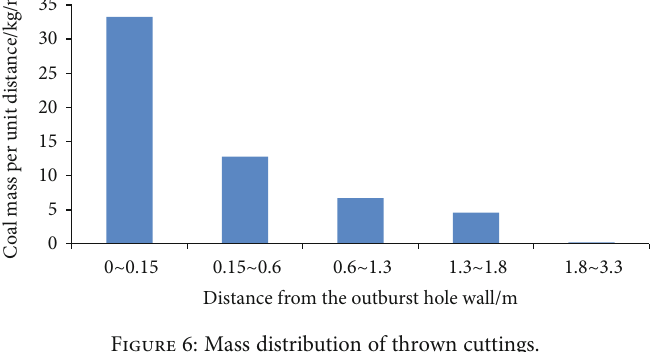
Figure 6: Mass distribution of thrown cuttings.